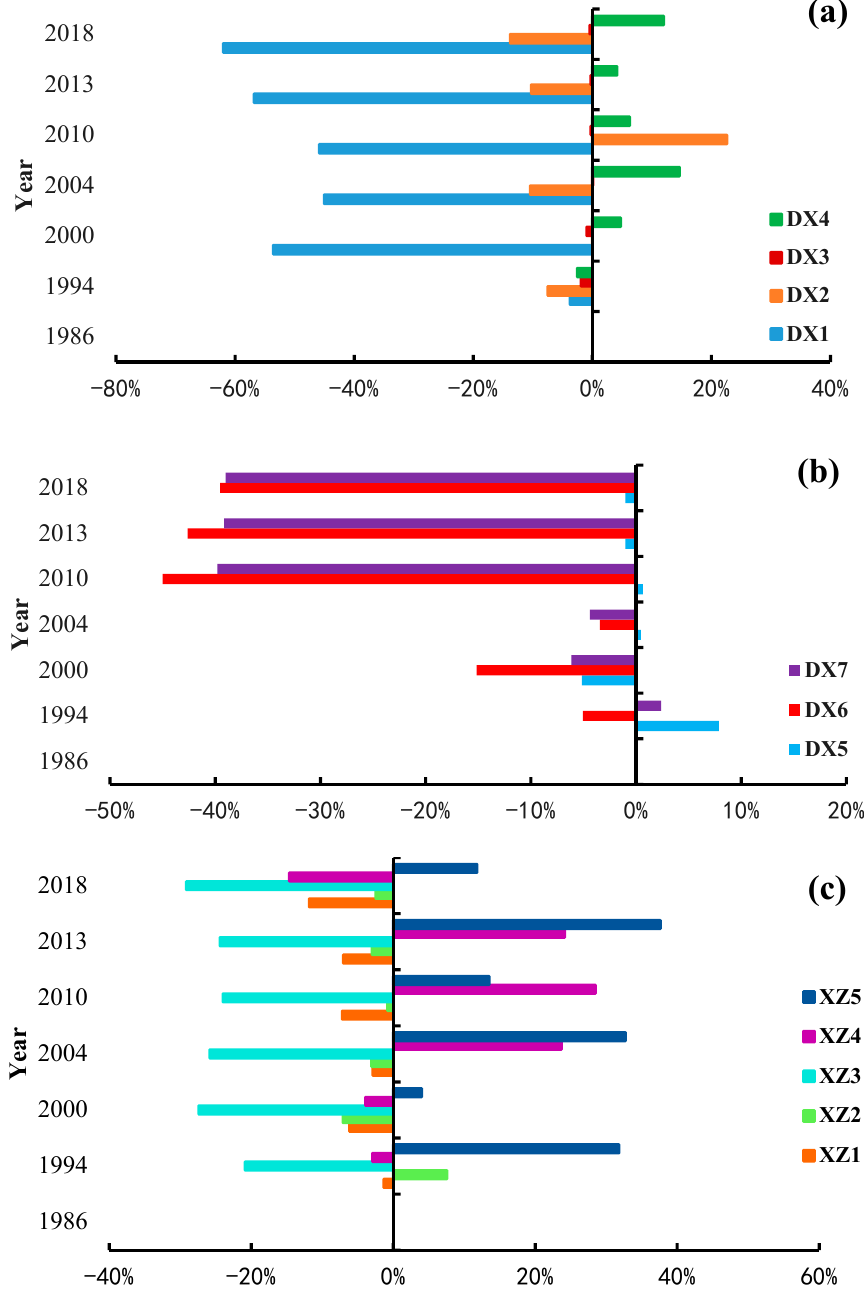
Figure 5. Channel bar area change rates along the middle reaches of the Hanjiang River from 1986–2018 ( a ) Danjiangkou-Xiangyang 1 (DX1)–DX4, ( b ) DX5–DX7, ( c ) (XZ1–XZ5).